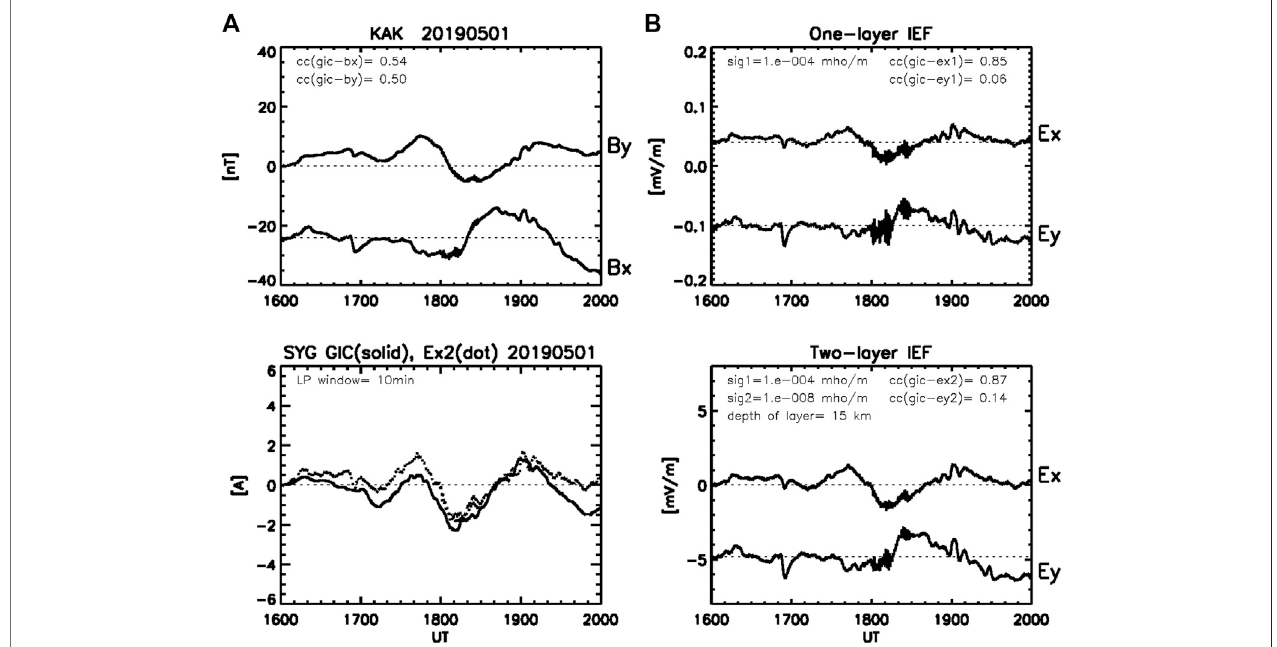
FIGURE 11 | (A) B x and B y observed at the Kakioka (KAK) magnetic observatory and GIC observed at the Shin-Yamaguchi (SYG) substation of the Chugoku ElectricPowerCompanyduring theDP2 fl uctuation eventwithperiodsof60 – 80 min intheearlymorning(16-20UT, 01-05 MLT).The GIC dataissmoothed byapplying the moving average over10 min. (B) E x and E y calculatedin one-and two-layer models. Theparameters in theframesarethesameasin Figure 1 except thatthe depth of the upper layer of the two-layer model is 15